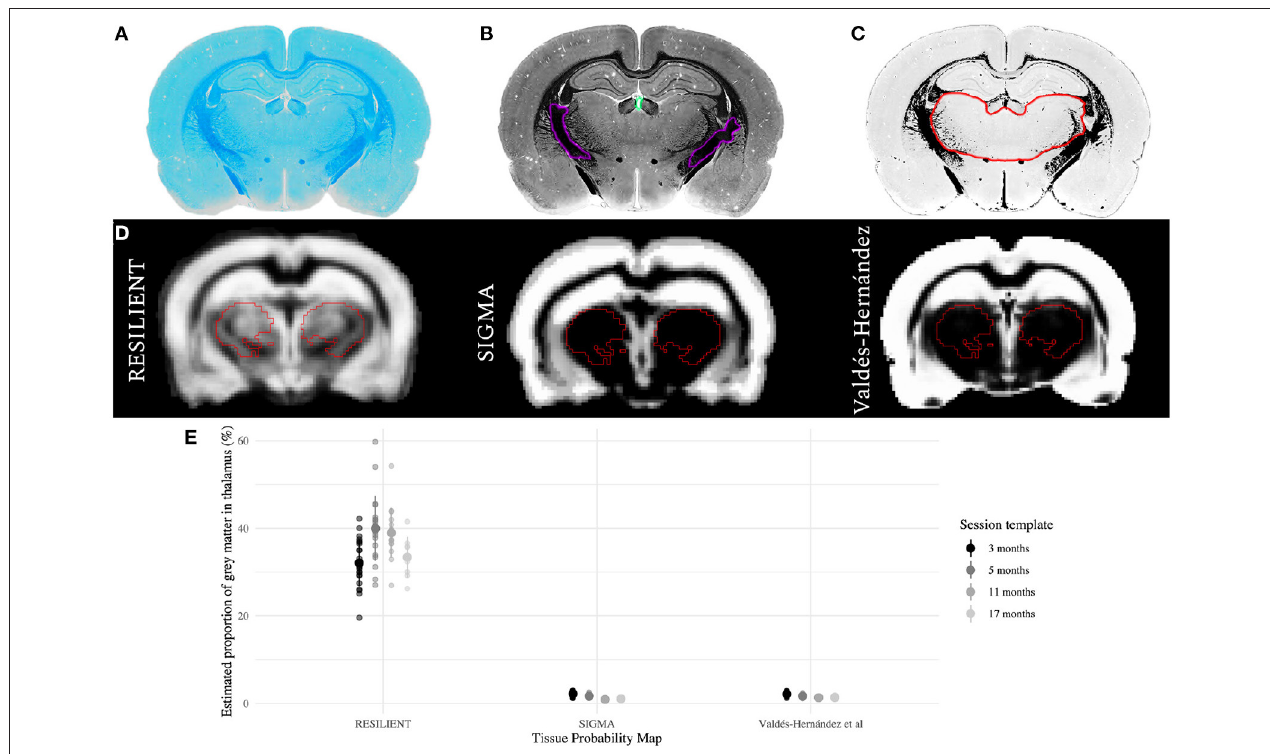
FIGURE 2 | Comparison of thalamic gray matter (GM) estimates. (A–C) Qualitative histological estimation of thalamic GM. A section stained for myelin with Luxol Fast Blue (A) was transformed to gray-scale (B) , and the mean ( ¯ X ) and standard deviation (SD) of pixel intensities were calculated within manually-delineated white matter (WM; purple) and ventricular (turquoise) regions of interest (ROI). The section was binarized (C) so that pixels which likely represent GM were valued 1 (white), while all others were valued 0 (black). The hand-delineated thalamus ROI (red overlay) is predominantly GM. (D) The RESILIENT TPM has higher prior probabilities of GM within the thalamic ROI (red overlay), derived from the SIGMA atlas, compared with existing resources. (E) GM estimates as a proportion of thalamic volume for each TPM set. The mean ± SD of estimates are shown for each